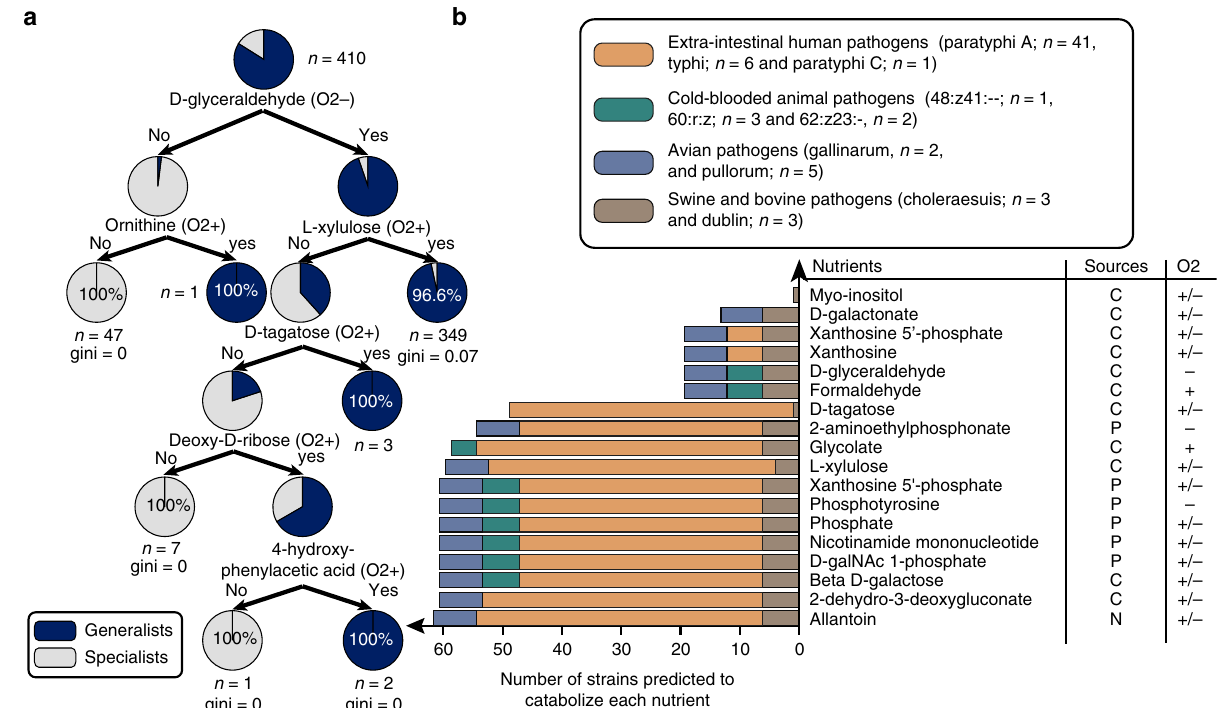
Fig. 4 Catabolic capabilities across host-restricted serovars. a Decision tree depicting differential nutrient utilization capabilities in 410 GEMs classi fi ed as host restricted (specialists) or non-host restricted (generalists). Specialists are distinguished from generalists by a general trend toward losing catabolic capabilities. b Catabolic capabilities of 67 host-restricted strains on 18 nutrient conditions (see Supplementary Fig. 6 for heat map). The conservation of certain catabolic capabilities among serovars restricted to a common niche hints at the availability of certain nutrients in a niche and highlights the importance of that function for survival. The classi fi cation of each serovar by its known colonization niche is listed along with the number of strains per serovar included in the analysis, see Supplementary Data 1 for more details on the strains. The nutrient sources are classi fi ed as C for carbon, P for phosphate, and N for nitrogen source and their basis to support growth in aerobic (O2 + ) and anaerobic (O2 − ) conditions are 54388.108) as well as the identi fi cation of nutrient auxotrophies